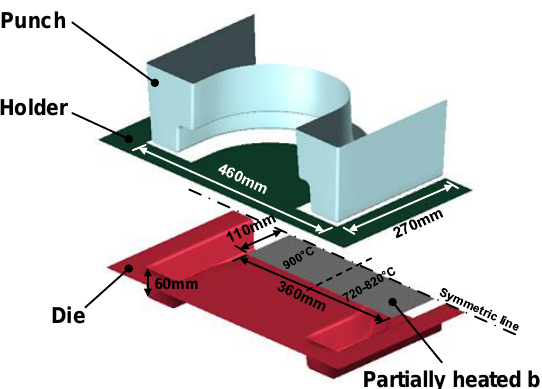
Figure 6. FE-simulation model for hot stamping of the lab-scale center pillar.